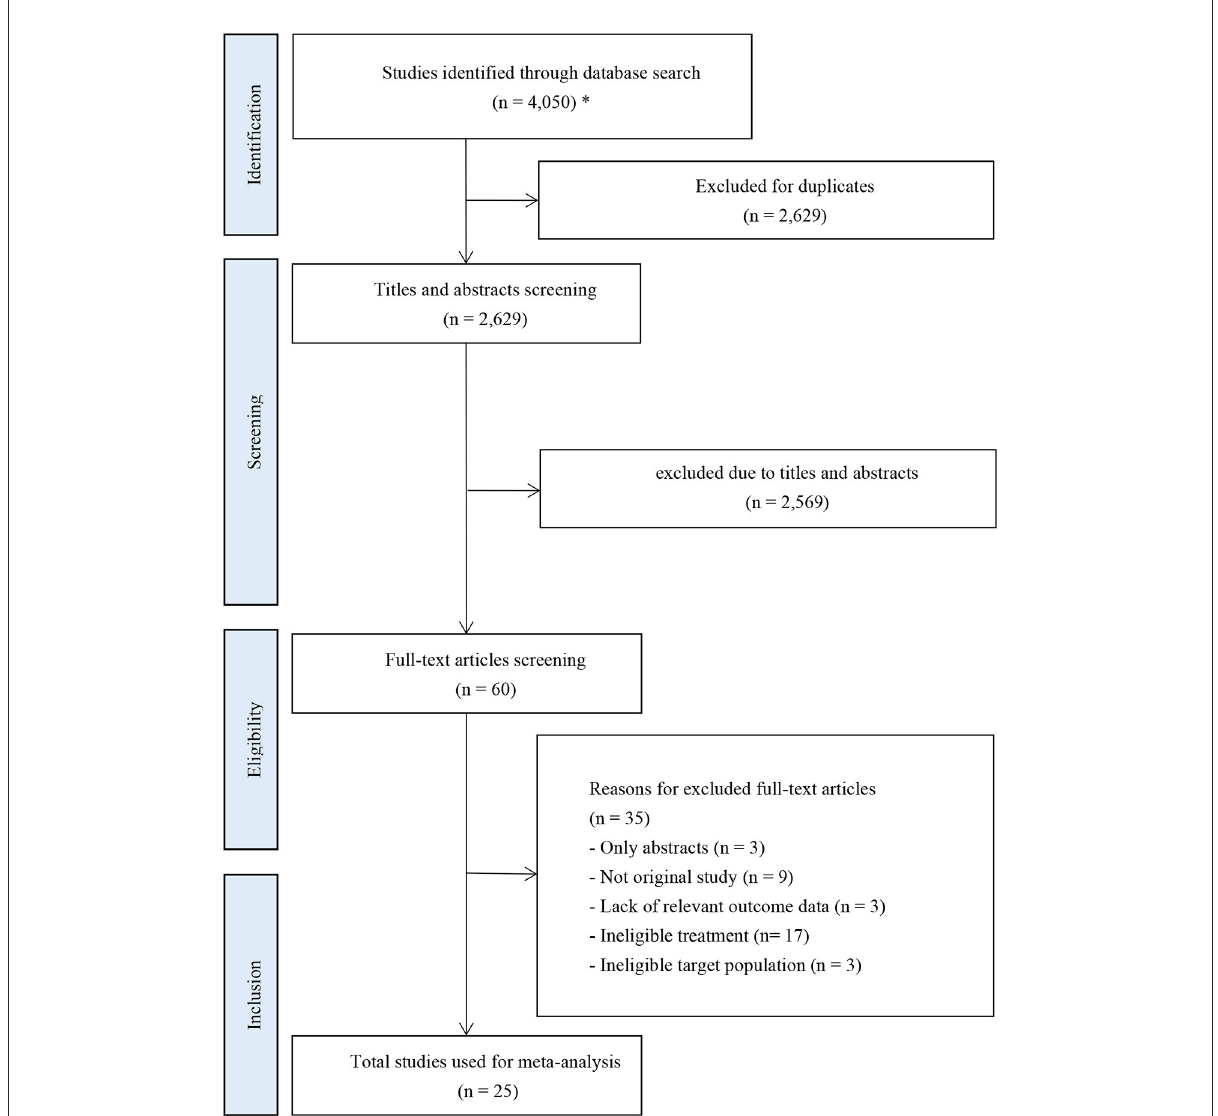
FIGURE1 PRISMA flow diagram of study inclusion. * The databases searched and the number of records retrieved are as follows: PubMed ( n = 1,328); Embase ( n = 1,936); Cochrane Library ( n = 761); ClinicalTrials.gov ( n = 25).